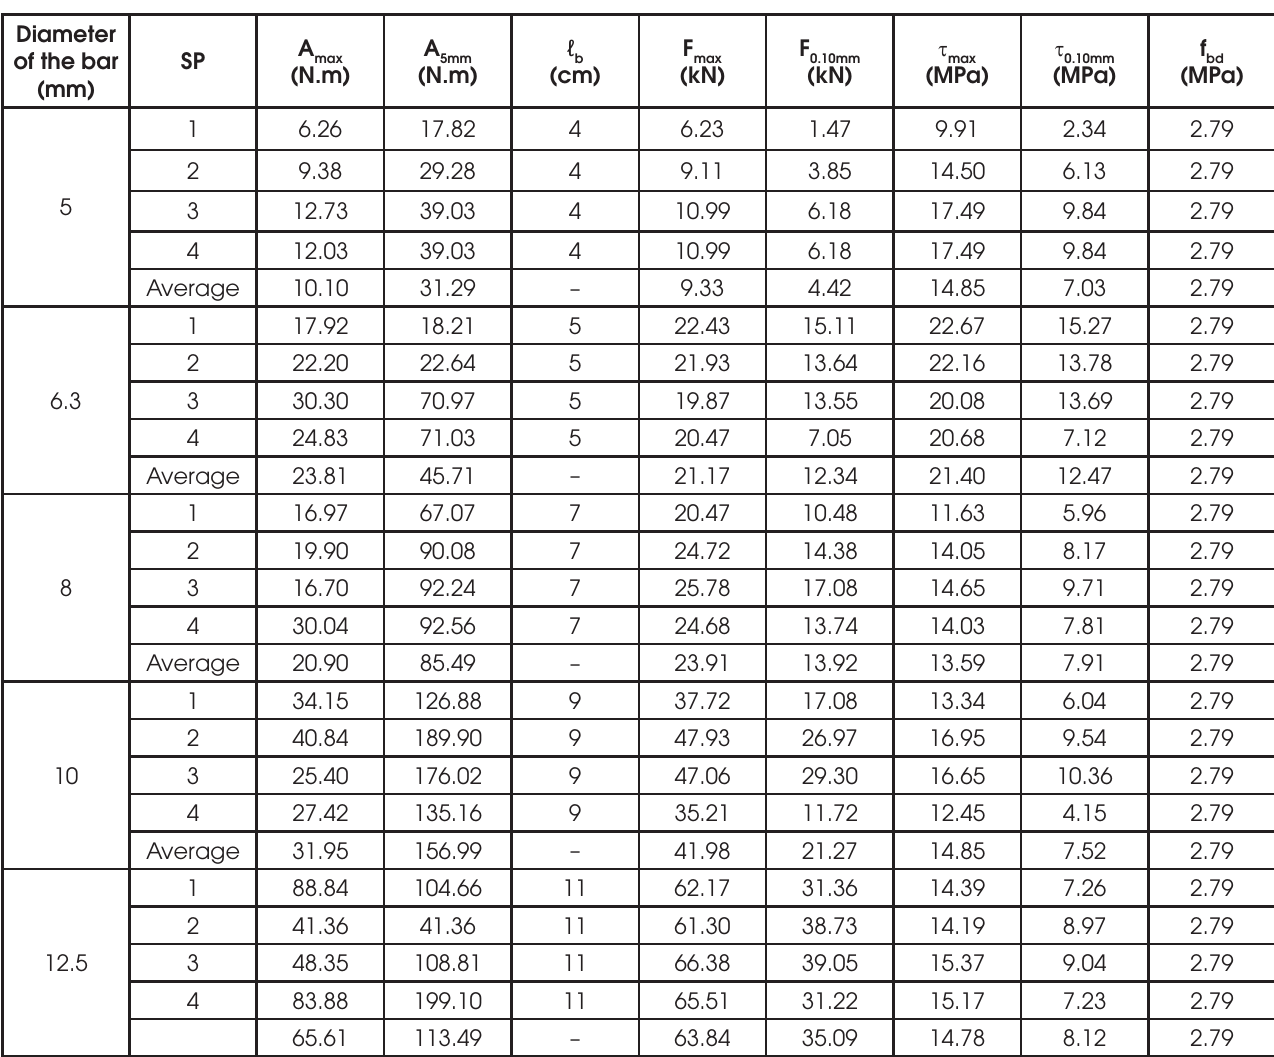
Results of pull-out tests with models of OC